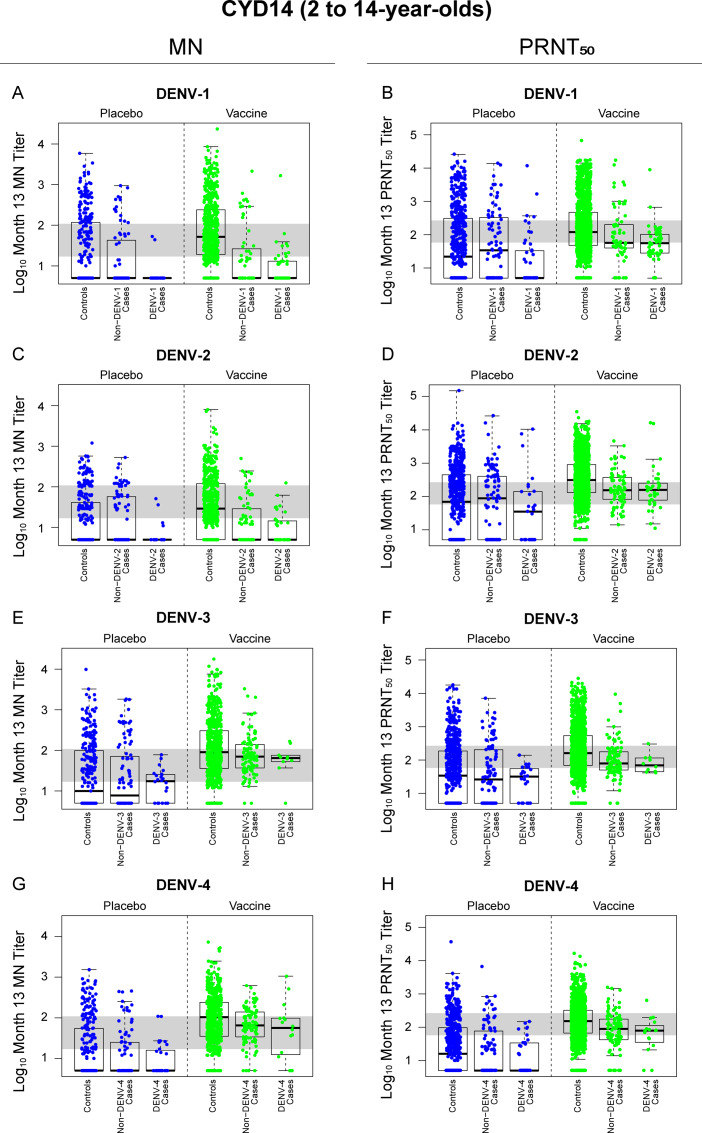
Distributions of log10 Month 13 MN (Panels A, C, E, G) and PRNT50 (Panels B, D, F, H) titers in CYD14 participants (all ages = 2 to 14 years old), stratified by treatment group and case status (serotype-matched vs serotype-mismatched cases).The gray horizontal shaded band denotes the middle third of nAb responses (log10 MN titer = 1.23 − 2.03; log10 PRNT50 titer 1.76 − 2.42). A “matched-serotype case” is one where the VCD-causing virus was of the same serotype as the virus used in the nAb assay; a “nonmatched-serotype case” is one where the VCD-causing virus was of a different serotype than the virus used in the nAb assay.